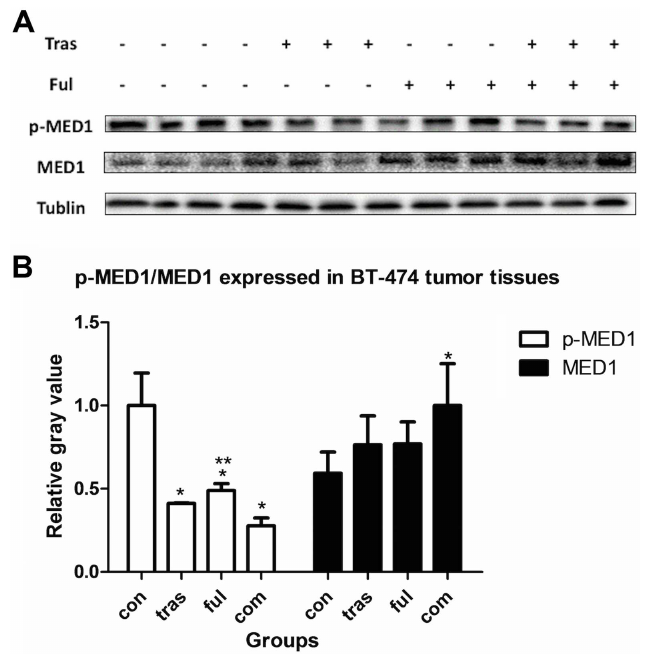
Fig 10. Immunoblot analysis of the levels of the proteins p-MED1 and MED1 expressedin BT-474 tumor xenografts. Three samplesfrom each group were randomly selected. Similar results were obtained after two experimental repeats. Thus, representative bandsfrom a singleexperimentare shownhere. Trastuzumab and fulvestrant as singleagents decreased levels of the protein p-MED1 ( P < 0.05)and the combination resultedin lower expressionlevels when comparedwith fulvestrant alone ( P = 0.039). In addition, total protein levels of MED1 increasedin the combination group comparedwith the vehicle-treated group ( P =